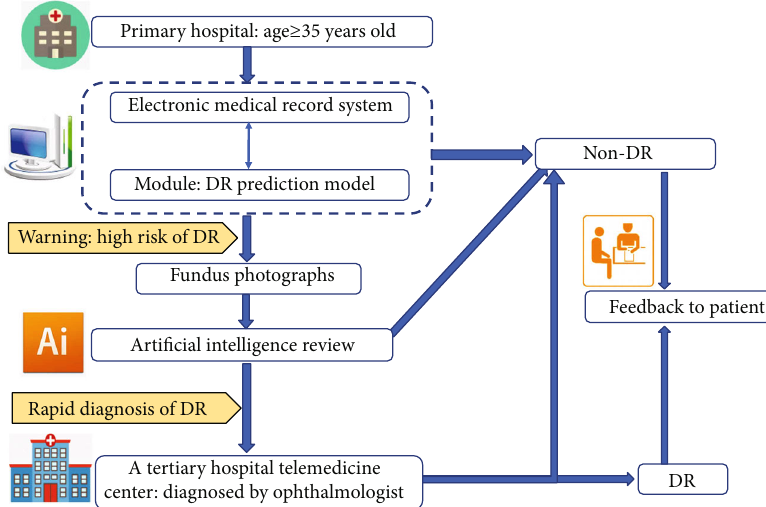
Figure 3: The procedure of DR diagnosis in primary